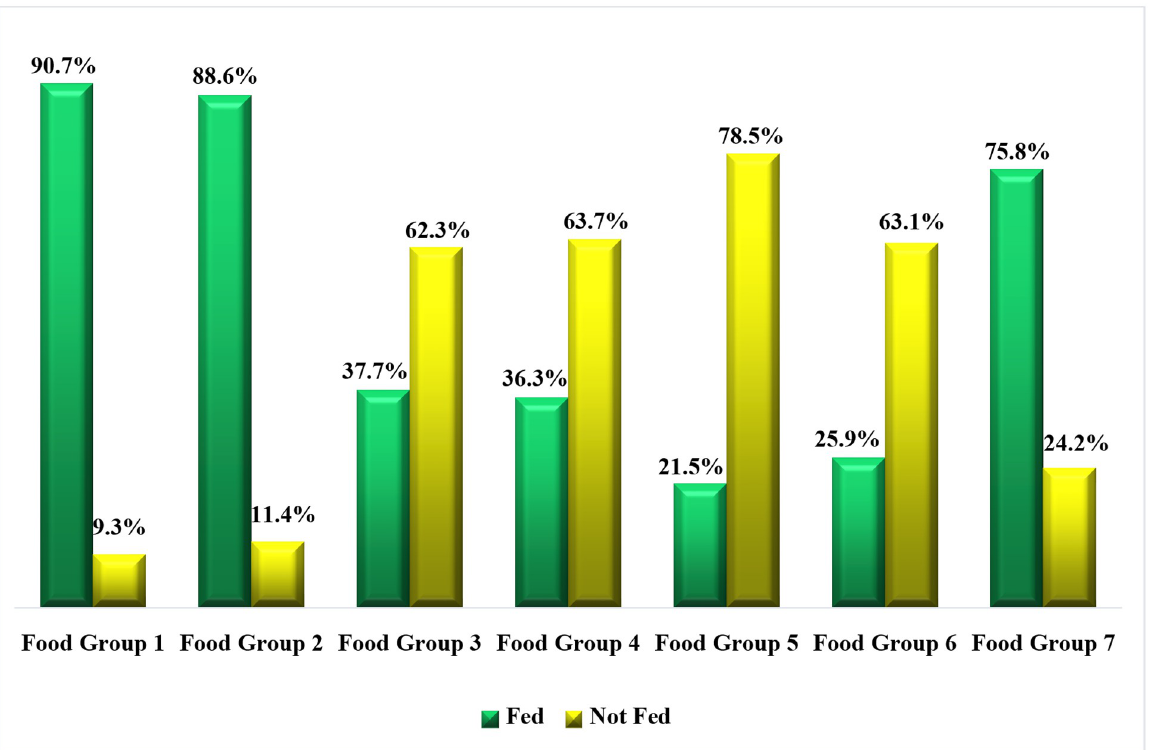
Fig 4. Proportions distributions of caregivers’ feeding practices of dietary diversity based on groups of foods. Source : Field Data (2022).